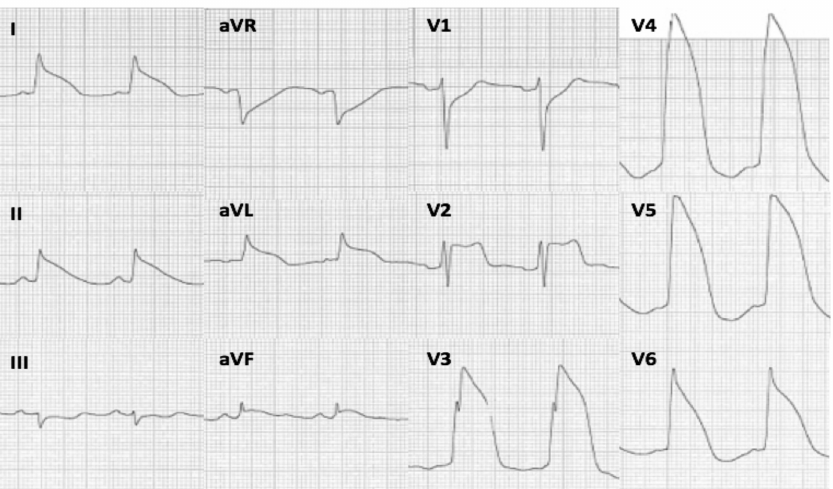
Figure 2. Electrocardiogram of a 68-year-old male patient who presented to the emergency depart- ment for chest pain. A triangular QRS-ST-T waveform was appreciable on anterolateral and inferior leads. Shortly after the ECG recording, the patient had PVF, requiring urgent defibrillation. Coronary angiography showed an occlusion of the proximal left anterior descending coronary